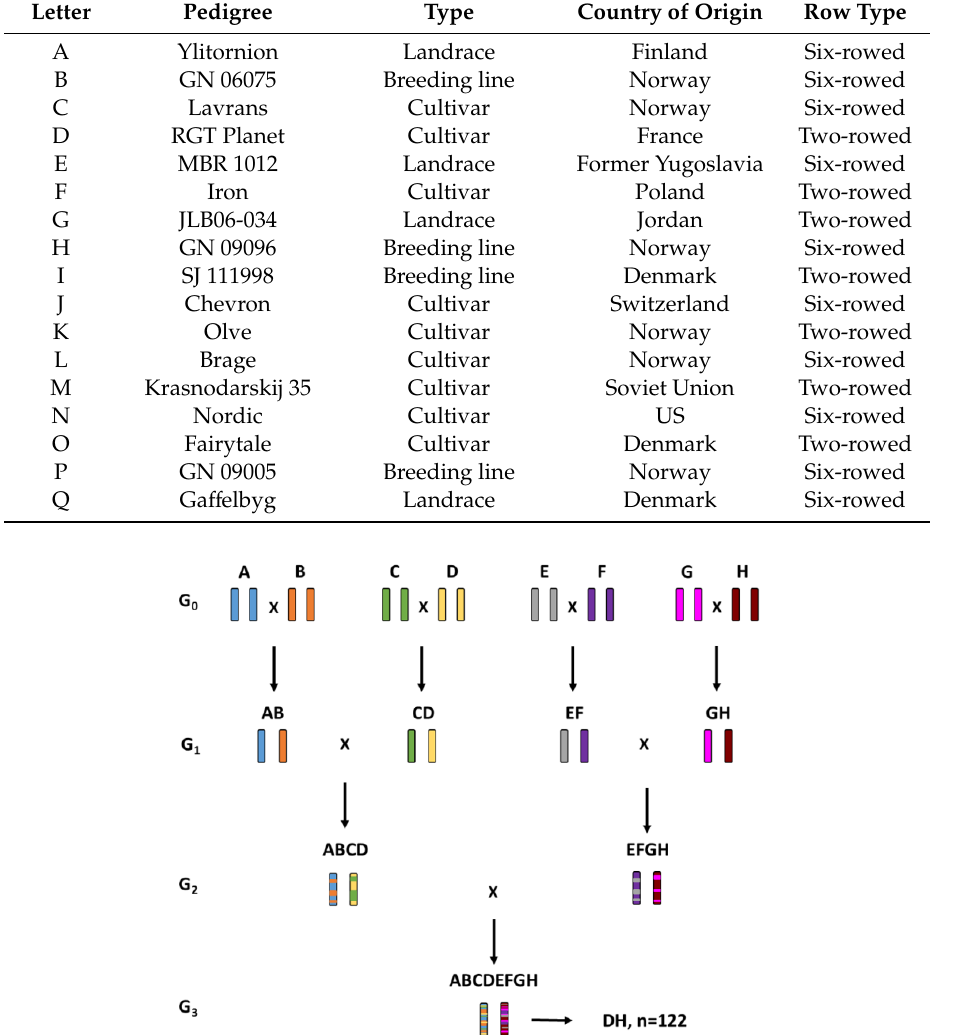
Table 1. Founders of the four barley MAGIC populations.